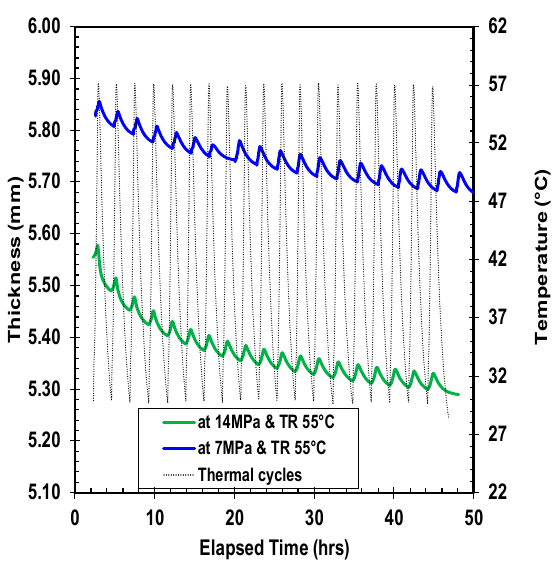
Figure 9. Ratcheting of HDPE under 7 and 14 MPa of stress.